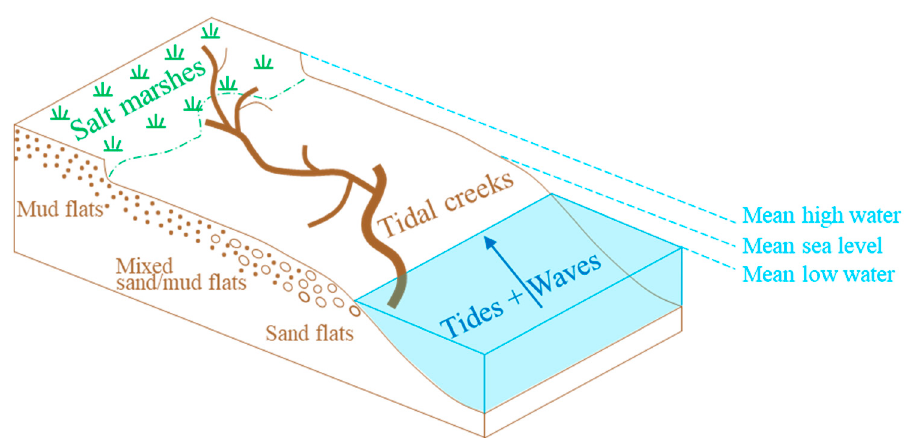
Figure 1. A profile view of sediment zonation (modified from [11]).